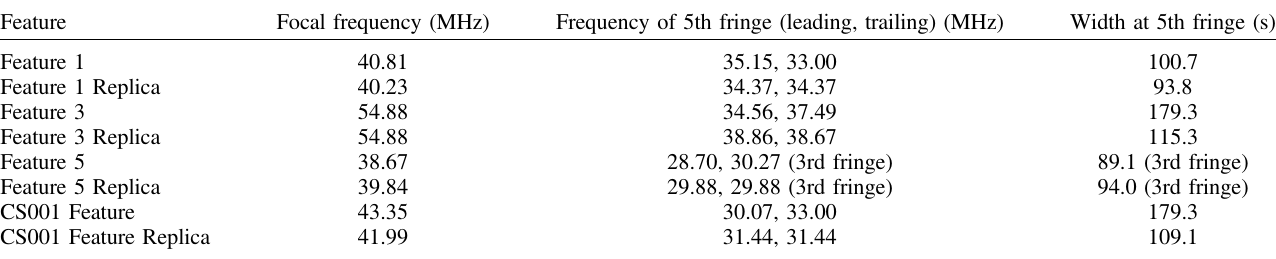
Table 2. The characteristic values of observed and modelled features. For feature 5 the 3rd fringe is considered instead of the 5th fringe as the the 5th fringe is not within the observing